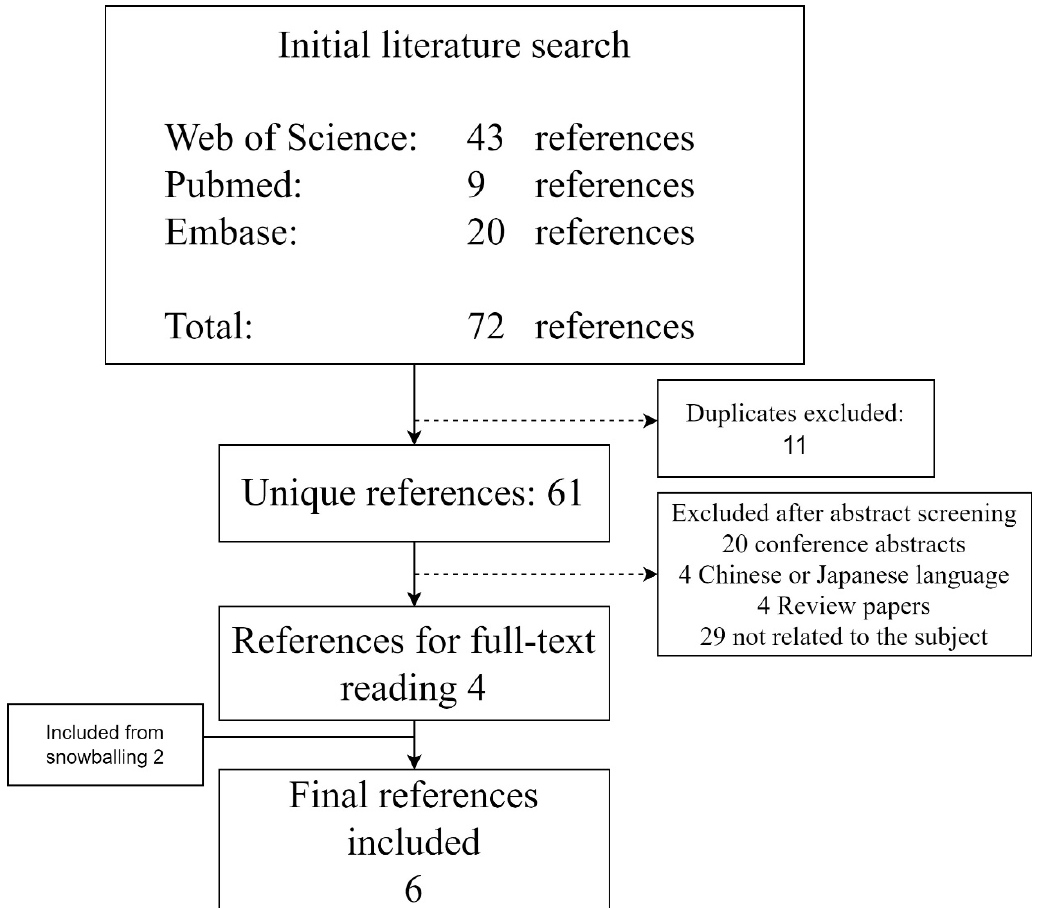
Figure 1. The flow of references from the initial literature search on 10 June 2022 on colon capsule endoscopy using castor oil in the bowel preparation regimen .